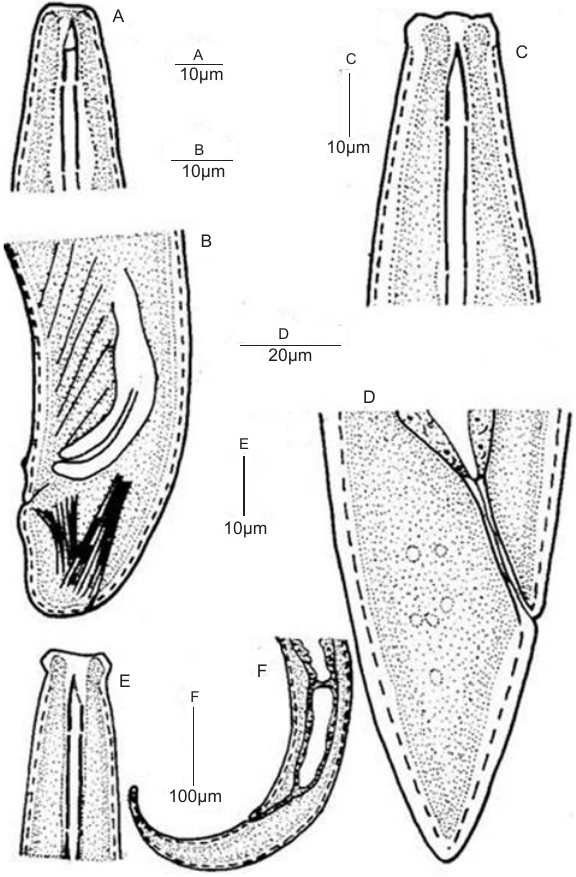
Fig.2. Mesodorylaimus subtiloides (Paetzold, 1958 Andrássy, 1959 A - Anterior end; B - Posterior